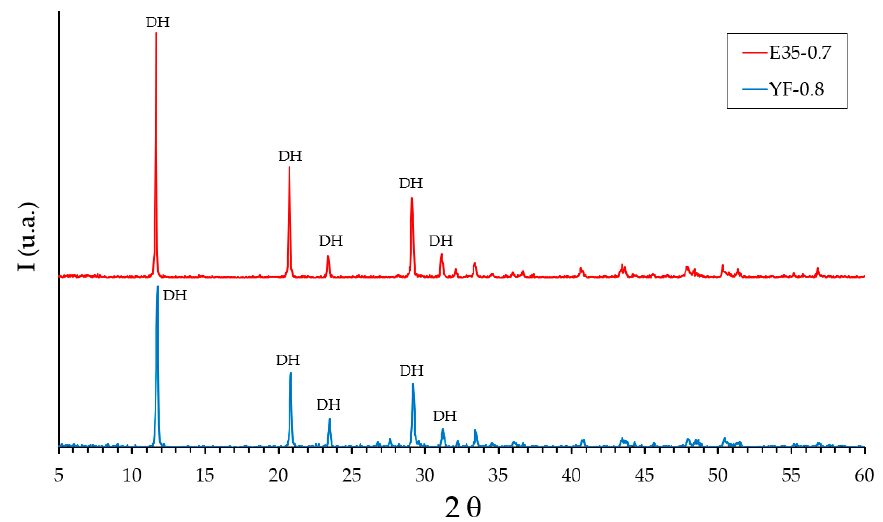
Figure 17. Results of the analysis by X-ray diffraction of the test specimens YF-0.8 and E35-0.7 at the age of 7 days. DH: dihydrate.